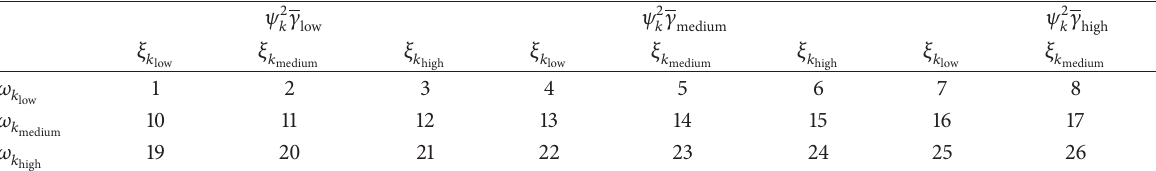
Table 5: Case description.